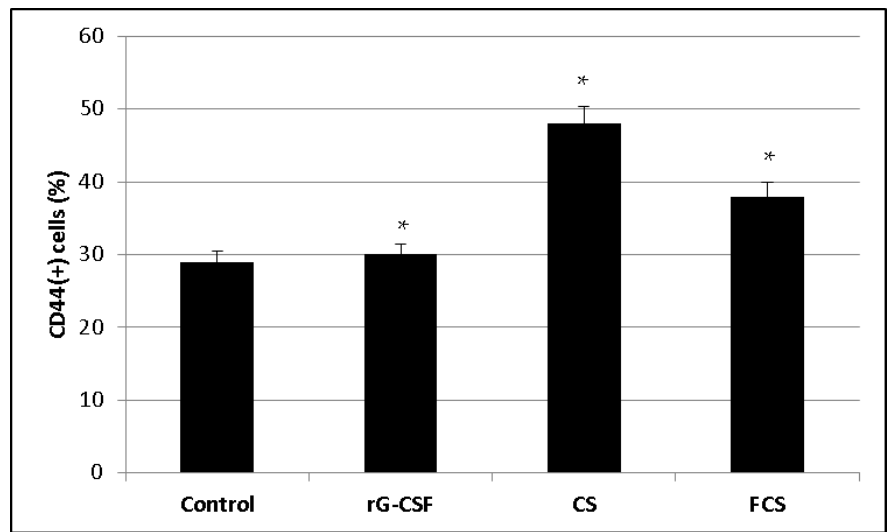
Figure 9. Level of CD44(+) nuclear bone marrow cells (%) after treatment with recombinant granulocyte colony-stimulating factor (r G-CSF), chondroitin sulfate ( CS ) and fucosylated chondroitin sulfate ( FCS ) (mean ± SD, p < 0.05). * p < 0.05 vs. control.